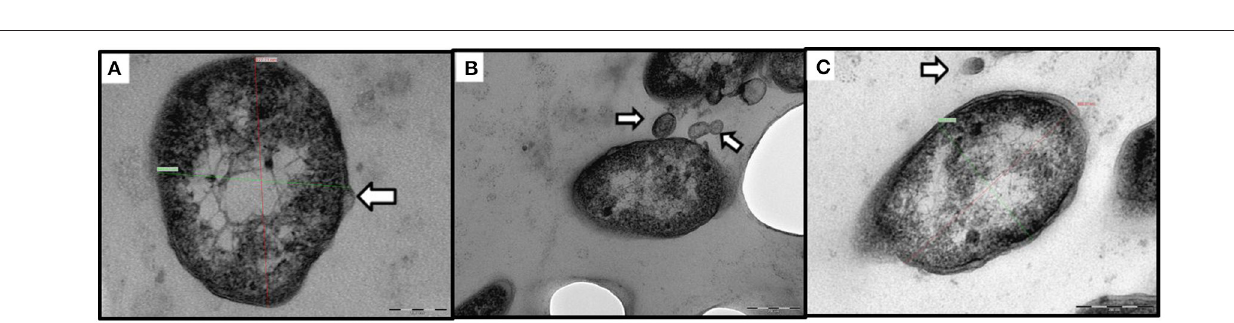
FIGURE 2 | Transmission electron micrographs of outer membrane vesicles (OMV) like structures. (A–C) Extracellular localization of Francisella -like cells, the white arrows indicate OMV-like structures. (A) Bacterial membrane blebbing (scale bar = 100nm). (B) Budding and secretion of vesicular membranous bodies (scale bar = 200nm). (C) Bacterial cell next to a free floating vesicle (scale bar =